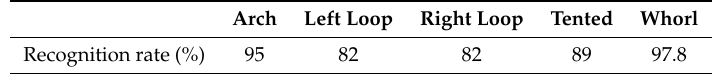
Table 11. Fingerprint classification results with the TemplateStruct features vector.